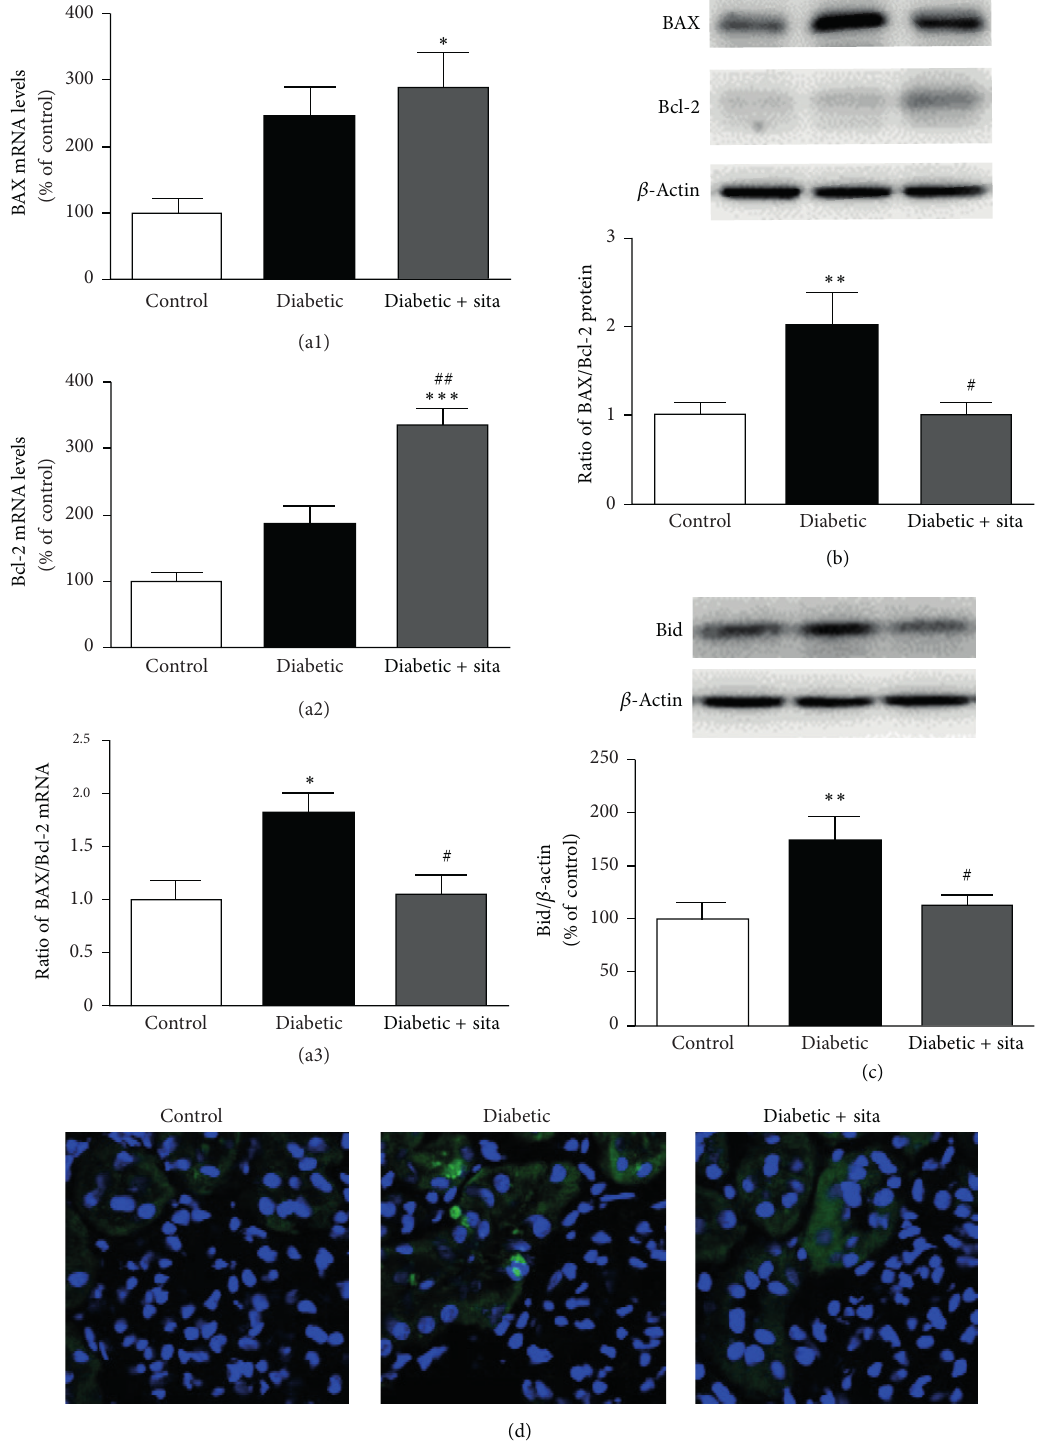
Figure6:EffectofsitagliptintreatmentinBAX,Bcl-2, andBidcontentandTUNEL-positivecellsinthediabetickidney. (a)mRNAexpression of BAX (a1) and Bcl-2 (a2) in the kidney and BAX/Bcl-2 ratio (a3). (b) The protein levels of BAX and Bcl-2 and BAX/Bcl-2 ratio were assessed in total kidney cell lysates by Western Blotting in ZDF (+/+) and ZDF ( fa/fa ) nontreated or treated with sitagliptin. (c) The protein levels of Bid were assessed in total kidney cell lysates by Western Blotting in ZDF (+/+) and ZDF ( fa/fa ) nontreated or treated with sitagliptin. The Western Blots presented are representative of each group of animals. Data are expressed as percentage of control and represent the mean ± SEM ( 𝑛 ≥ 6 per group); ∗ 𝑃 < 0.05 , ∗∗ 𝑃 < 0.01 , and ∗∗∗ 𝑃 < 0.001 significantly different from control; # 𝑃 < 0.05 and ## 𝑃 < 0.01 significantly different from diabetic. (d) Representative confocal images for each group of animals showing TUNEL-positive (green) cells and nuclear counterstaining with DAPI (blue) in kidney sections (6 𝜇